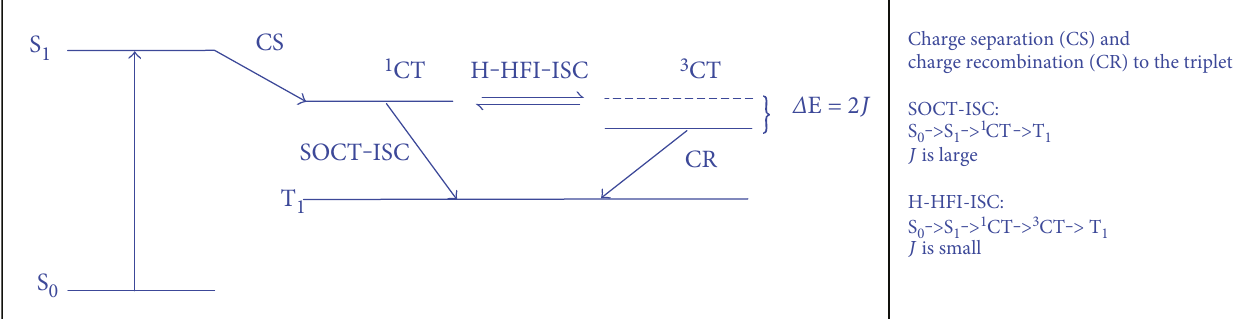
Figure 6: Representation of the processes described earlier for molecular donor-acceptor systems [51]: charge separation leads to a charge transfer state; geminate charge recombination to the triplet state can occur through proton hyper fi ne interactions (H-HFI-ISC) and through spin-orbit charge transfer intersystem crossing (SOCT-ISC). The energy di ff erence of the singlet and triplet charge transfer state is twice the exchange integral ( J ). See Figure 7 for application of these aspects to non-geminate charge recombination in polymer